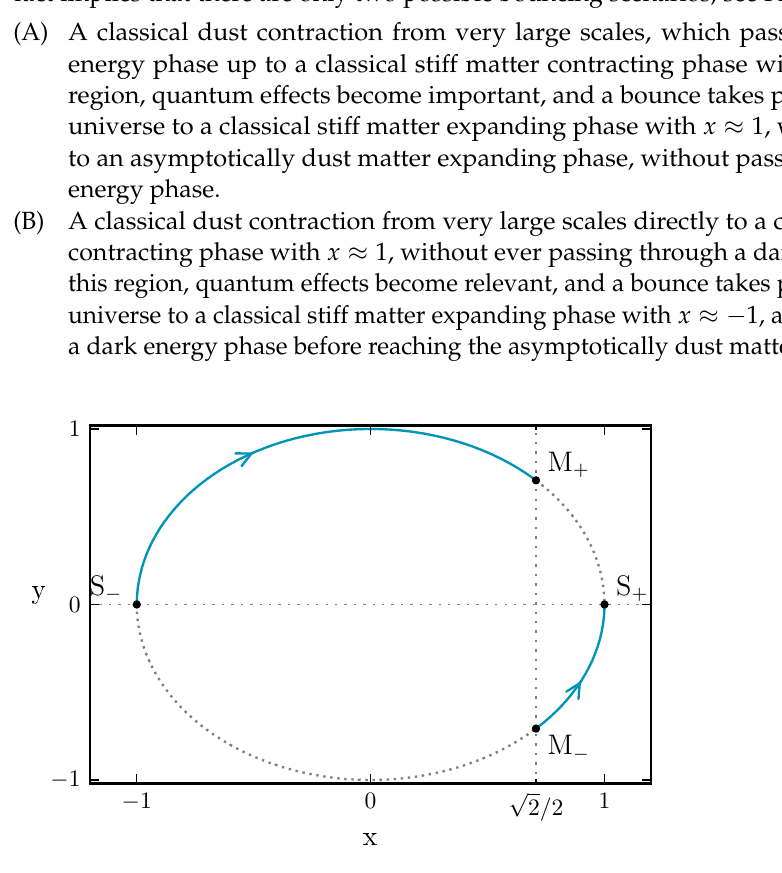
Figure 6. Case A: the scalar field has a dark energy phase during contraction. This model cannot describe the dark energy in the future, since the matter attractor is reached